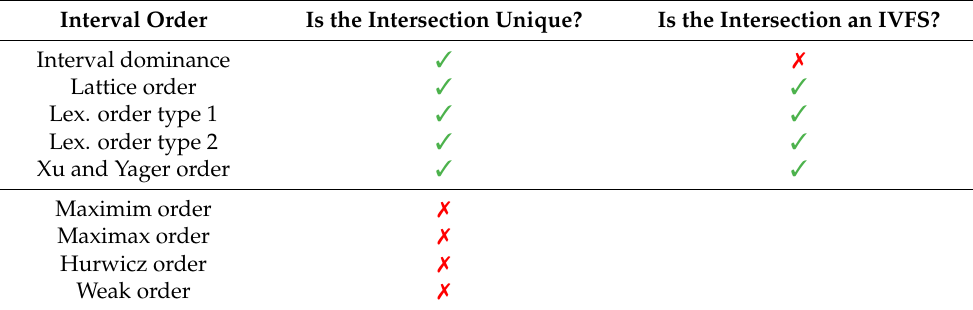
Table 2. Uniqueness of the intersection of